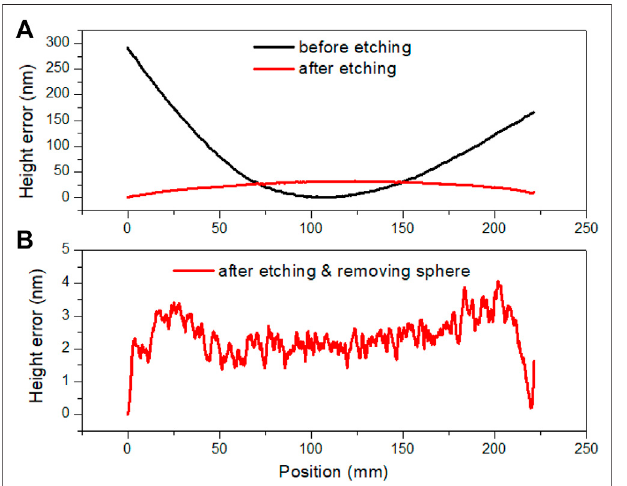
FIGURE 9 | RMS values of two-dimensional slope errors of HFM calculated at different spatial